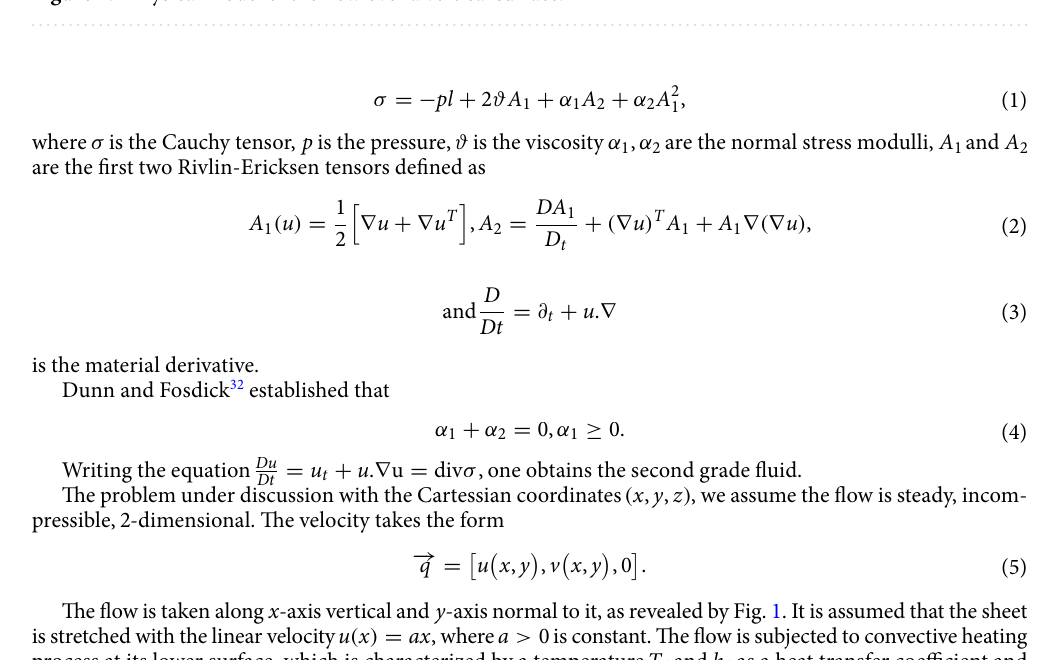
Figure 1. Physical model of the flow over a vertical